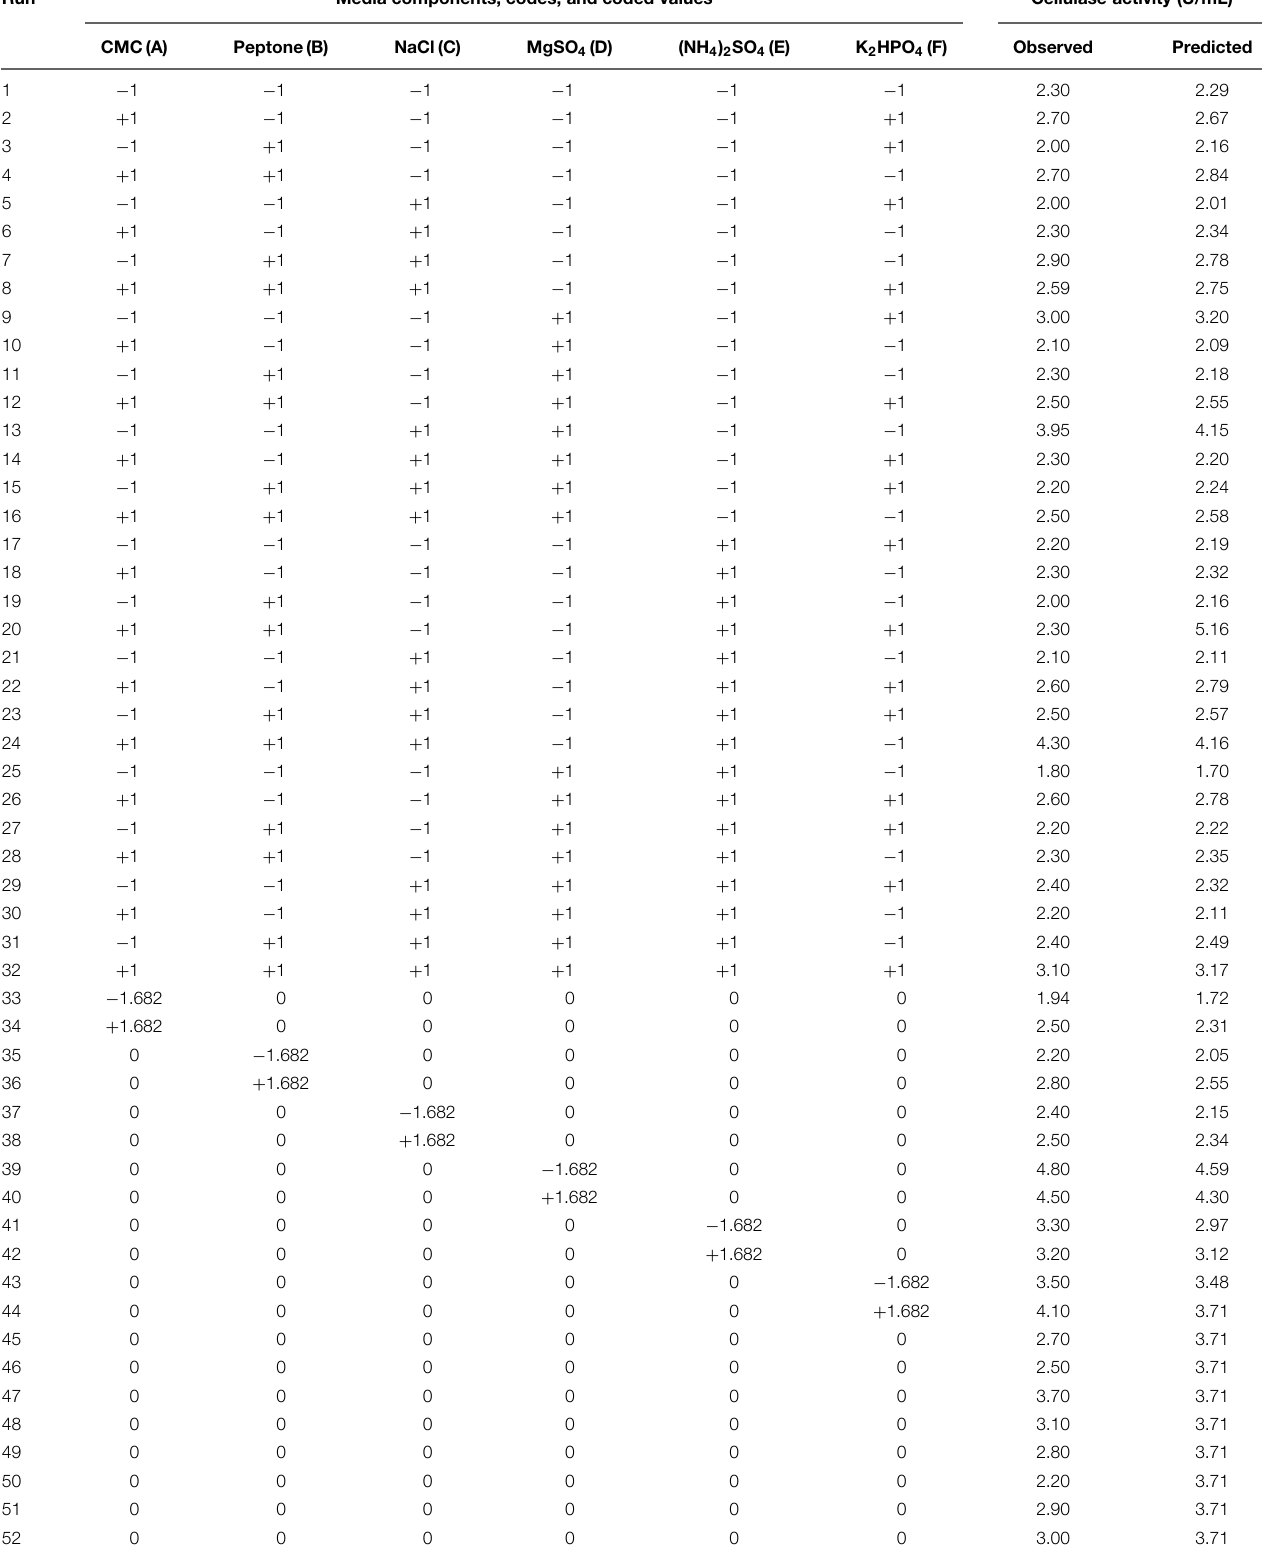
TABLE 2 | Central composite design matrix, observed, and predicted